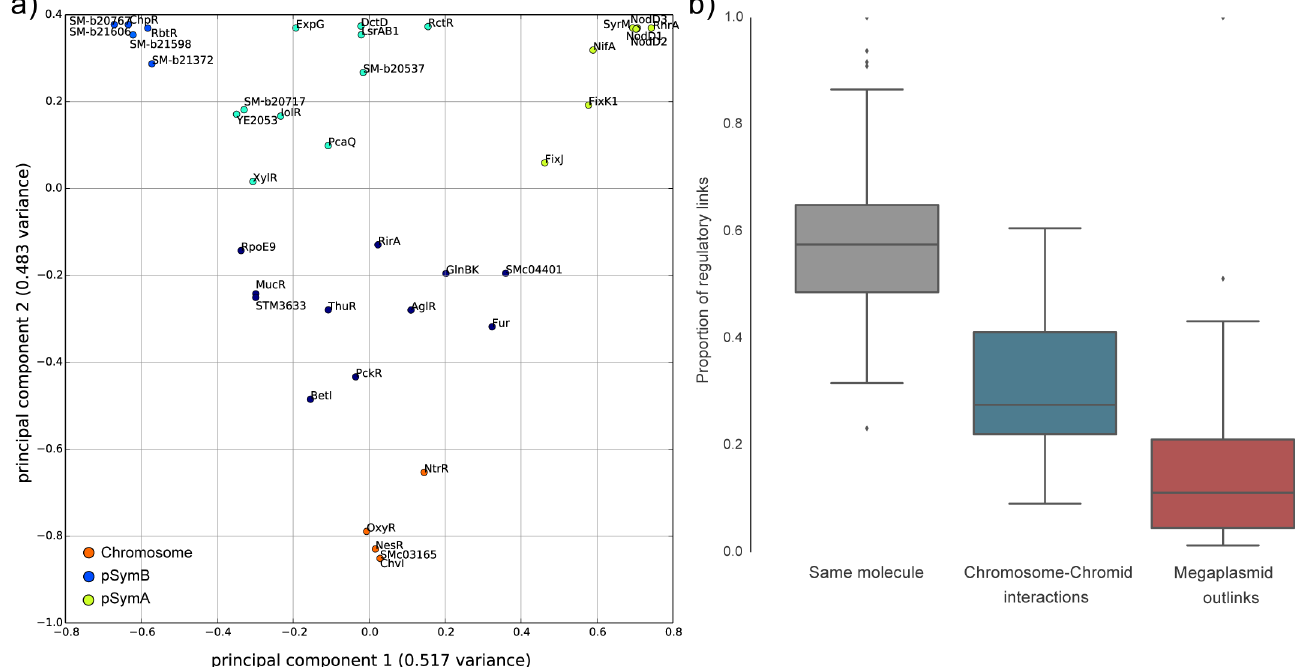
Fig 5. TFs preferentially associated with a replicon. a) K-means clustering of the normalized proportion of genes regulated in each of the three main replicons of S. meliloti , visualized in a two-dimensional PCA. The dark blue and cyan clusters contain TFs with no clear replicon preference; b) Variability in the number of regulatory links in the same replicon and between replicons. All differences are significant (t-test p-value <